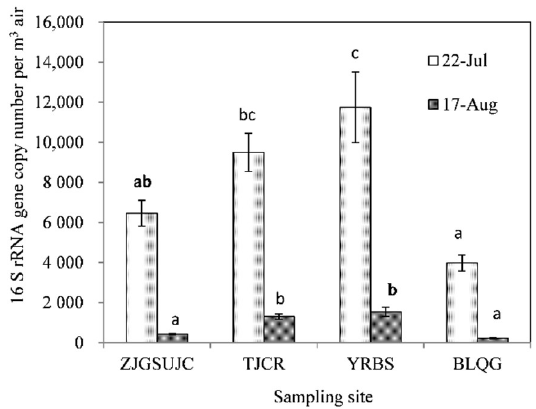
Figure 2. Airborne bacterial 16S rRNA gene copies as determined by quantitative real-time PCR beginning and end the heat event at four selected sampling sites in Hangzhou.